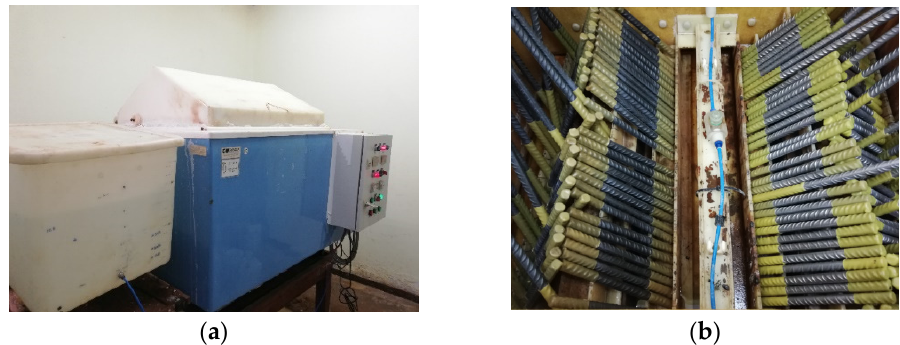
Figure 3. ( a ) View of salt spray chamber in laboratory and ( b ) view of the tested steel bars in the salt spray chamber.